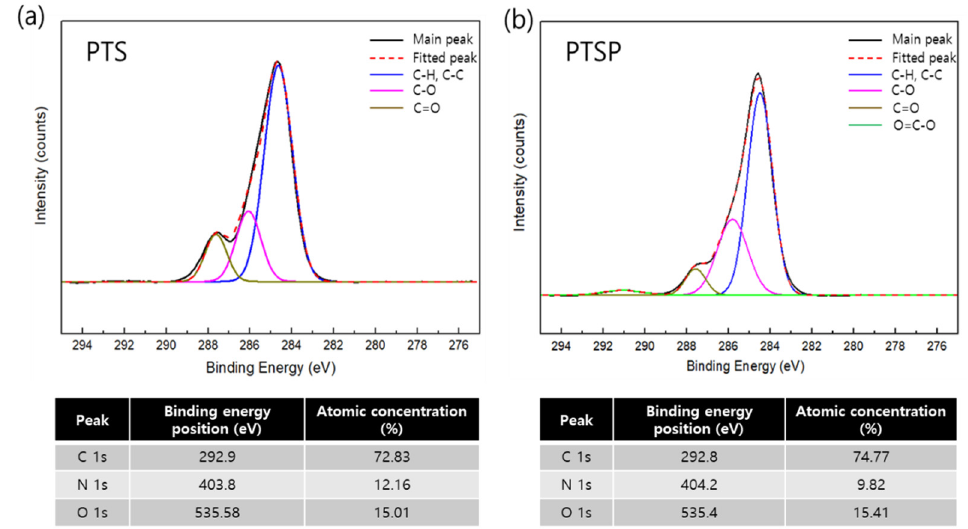
Figure 4. XPS graphs (C1s) and atomic concentration for ( a ) PTS and ( b ) PTSM membranes. The high-resolution C1s region (282–292 eV) of the PTSM specimens with PTS and mGO was analyzed by XPS analysis. In both specimens, the C-C and C-H peaks associated with carbide species were observed at the same position, that is, at 284.5 eV, as shown in Figure 4a,b [42]. In PTSP, a peak related to the C=O bonds formed after interfacial polymerization was found at 285.8 eV, and a peak resulting from the amide OCN was observed at 286.7 eV. A carboxyl group (O=C–O) peak found at 291.0 eV, attributed to GO, had a higher intensity (Figure 4b) [43–45].